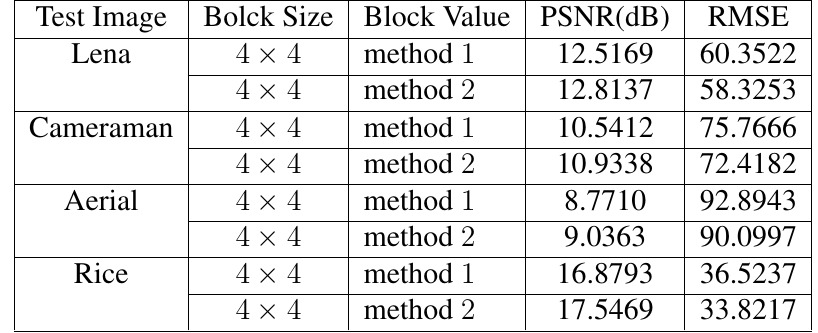
Table 3: Compression quality measures with 4 × 4 blocks using methods 1& 2